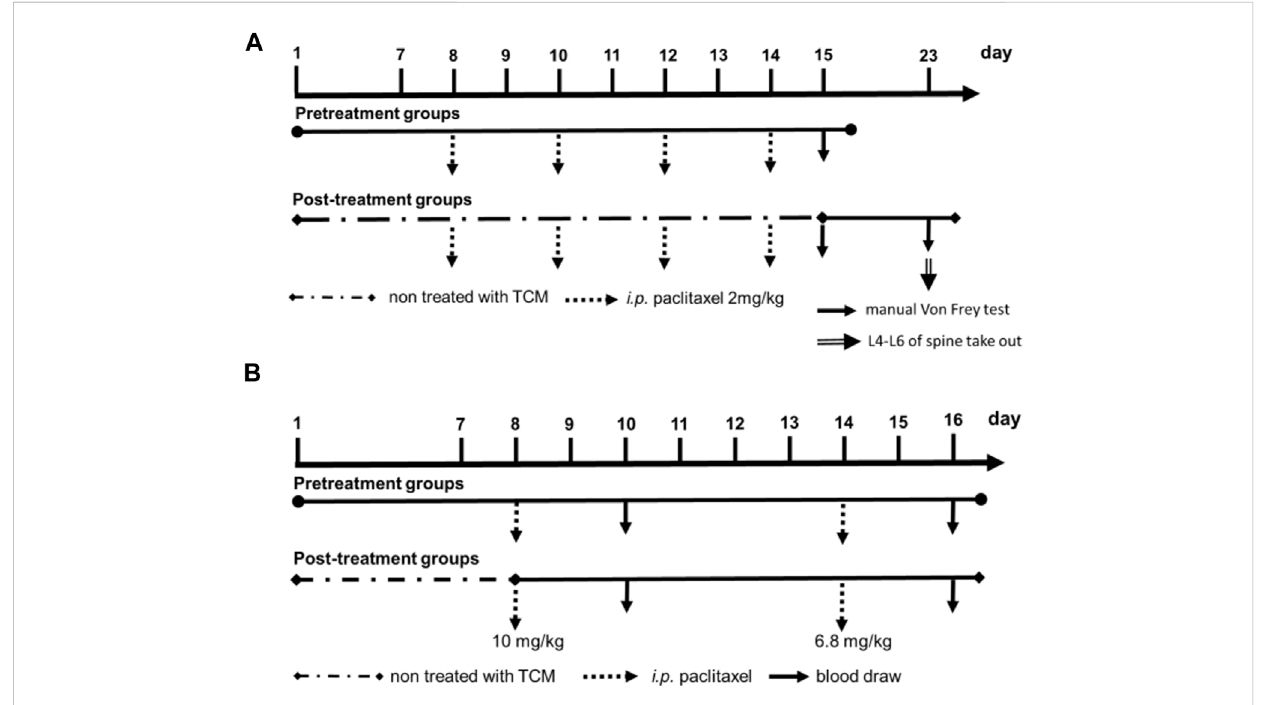
FIGURE 3 Experimental fl ow cart. (A) , paclitaxel-induced leukopenia in BALB/c mice model; (B) , pre-treatment and post-treatment of XSLZJT in the hyperalgesia animal model.